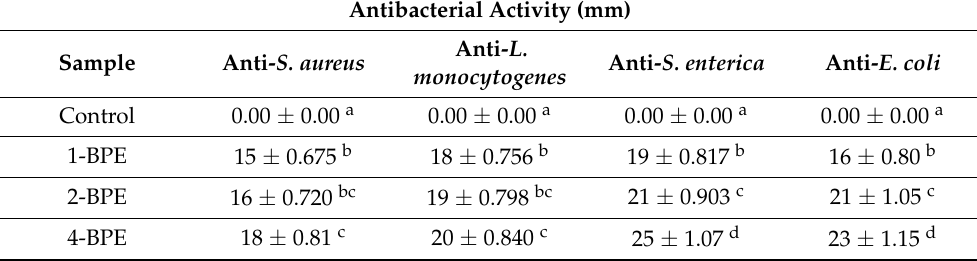
Table 4. Antibacterial activities of films.